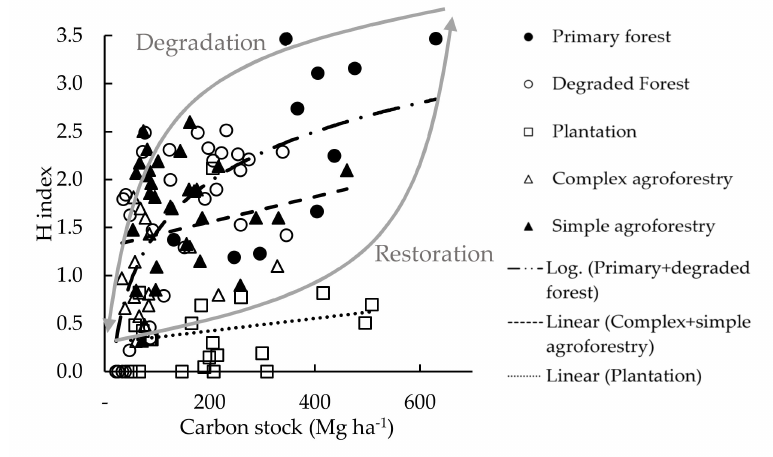
Figure 5. Total C stock and tree diversity (Shannon–Wiener index) in di ff erent land-use systems, n = 102 (primary data plus